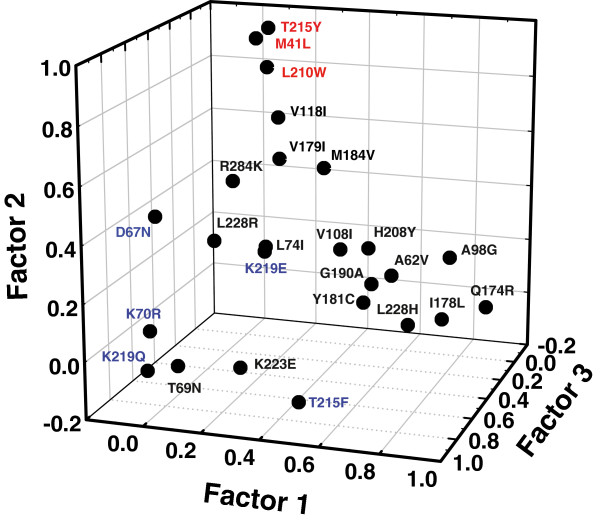
Principal axis factoring analysis of correlations between mutations associated with tenofovir/emtricitabine therapy failure. A factor scores plot (in rotated factor space) is shown. Amino acid changes with high coefficients of covariation are close together, while large distances separate those substitutions that show low or negative coefficients of association. Major mutations of the TAM1 and TAM2 complexes are indicated in red and blue, respectively.